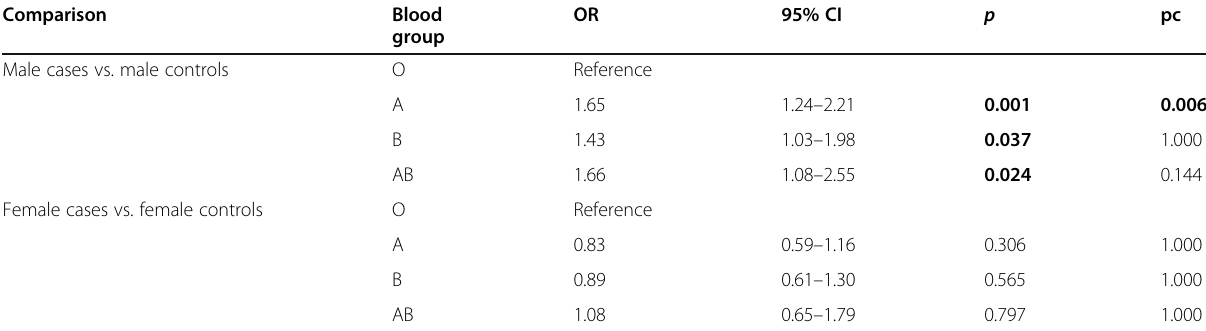
Table 5 Regression analysis of ABO blood groups in male and female COVID-19 cases Comparison Blood OR 95% CI p group